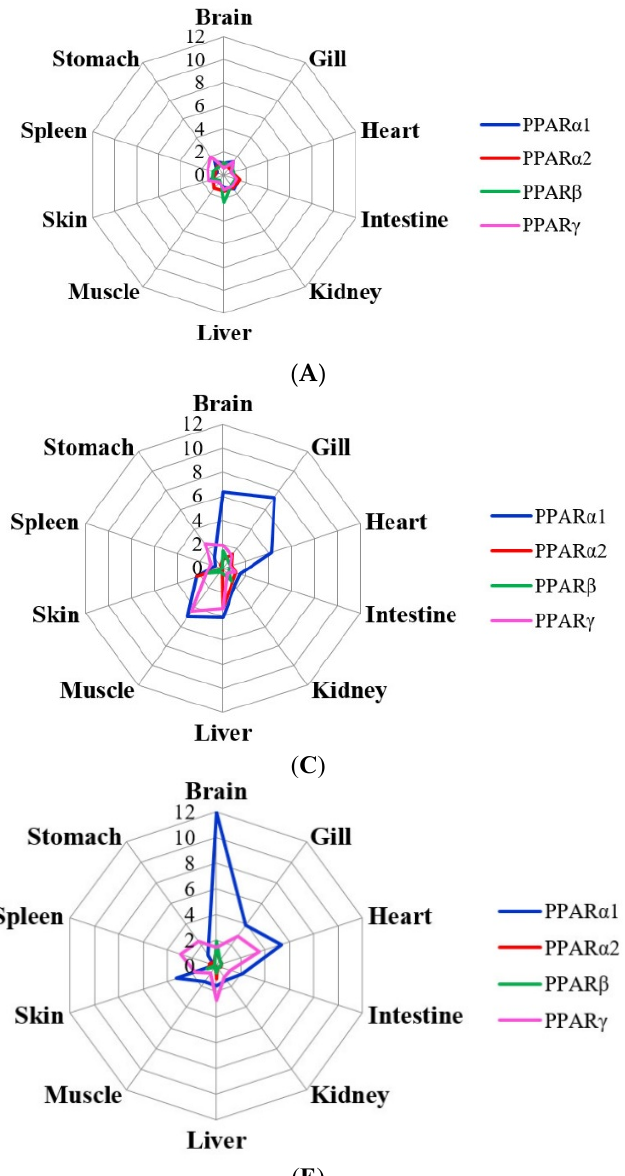
Figure 1. Expression values of PPAR genes in ten tissues at five temperatures (( A ), 14 °C; ( B ), 20 °C; ( C ), 23 °C; ( D ), 25 °C; ( E ), 28 °C).